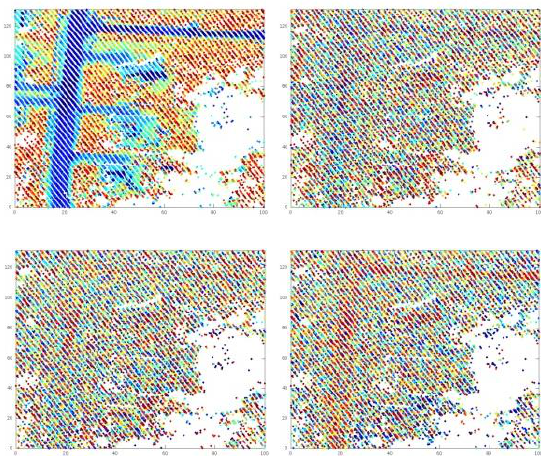
Figure 3: Magnitude, width, flattening, and skewness parameters in the test area